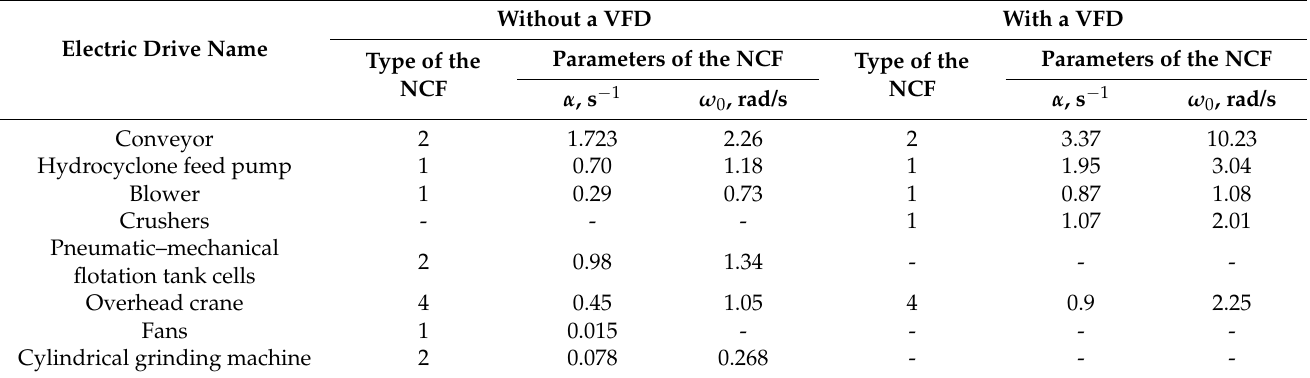
Figure 8. Fragment of the curve of active power consumption pneumatic–mechanical flotation tank cells without a VFD and his NCF. Table 9. Parameters of the various types of NCFs, with and without the use of a frequency converter.